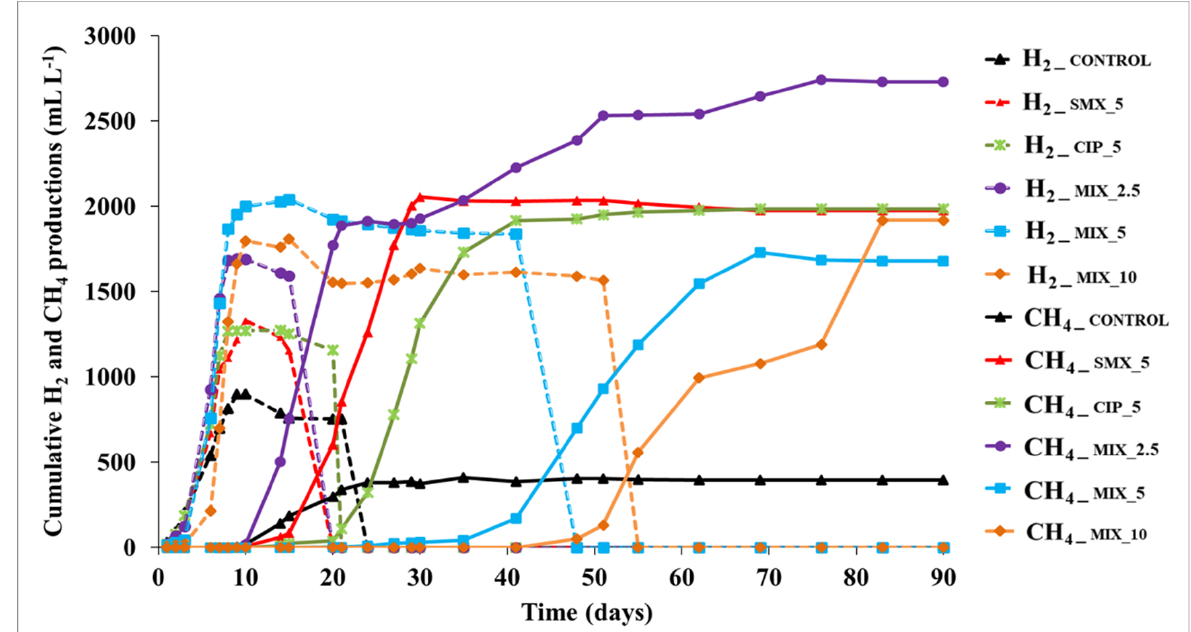
Figure 1. Cumulative H 2 and CH 4 production in all experimental conditions. Dotted lines and solid lines represent the cumulative production of H 2 and CH 4 , respectively (standard deviations < 10%).